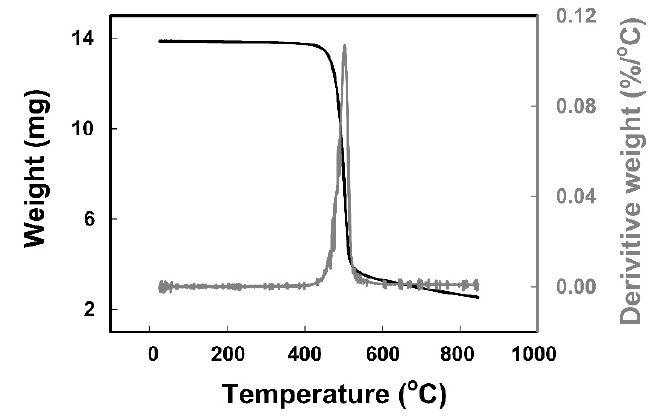
Figure 2. Typical thermogravimetric analysis (TGA) result. Black line: weight; grey line: derivative weight.